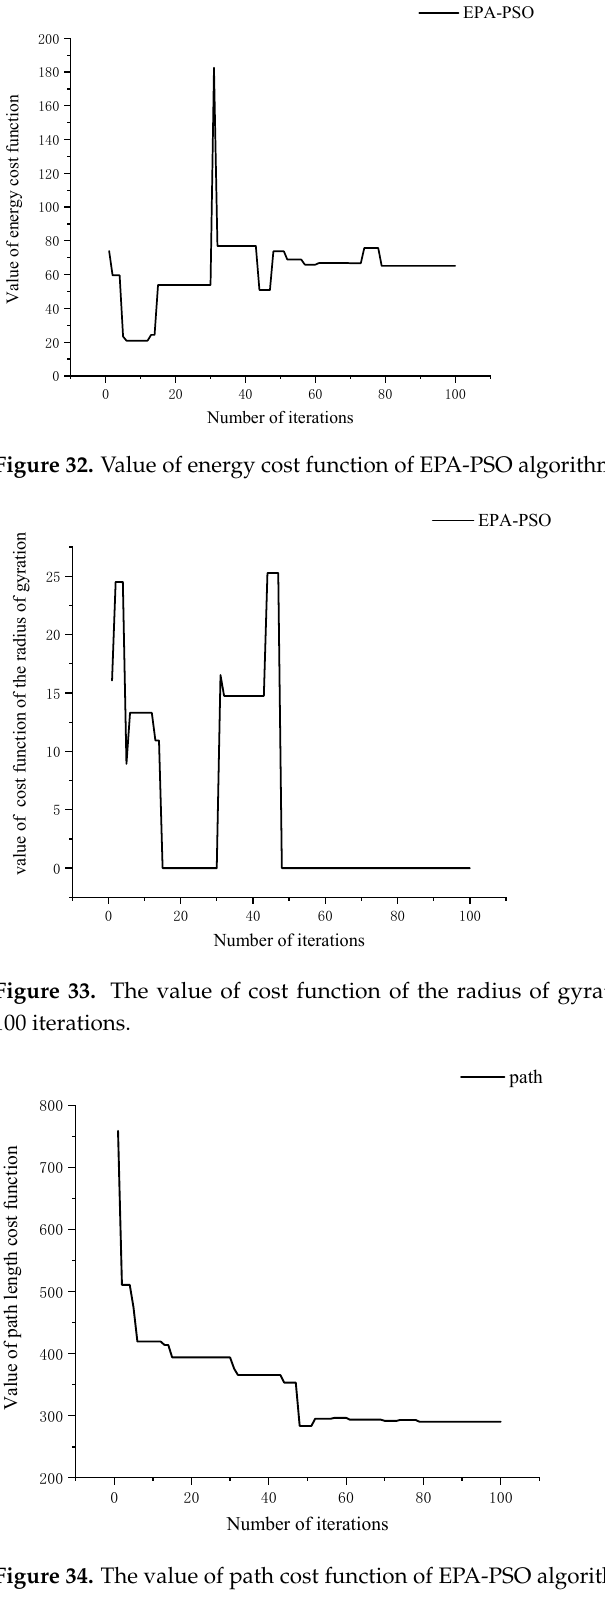
Figure 35. The weight of cost function of EPA-PSO algorithm after 100 iterations. According to the experimental results, it can be verified that the EPA-PSO algorithm can obtain a reliable path in the sea test experiment with a low flow rate, but if the actual marine environment is harsh, the result will become unreliable; meanwhile, for the curve shown in Figure 27, due to the error of the actual AUV motion control, the final tracking effect is not satisfactory, which also leads to the AUV consuming more energy and sailing a longer distance in the tracking task. The next step is to continue to study how to improve the control performance of AUV, so that AUV can track the optimal route planned by EPA-PSO algorithm as much as possible, and achieve the purpose of further reducing energy consumption during navigation.